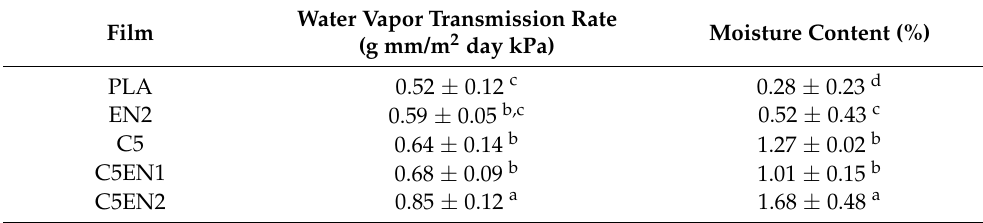
Table 2. Water vapor transmission rate and moisture content of PLA, C5, EN2, C5EN1, and C5EN2 films.